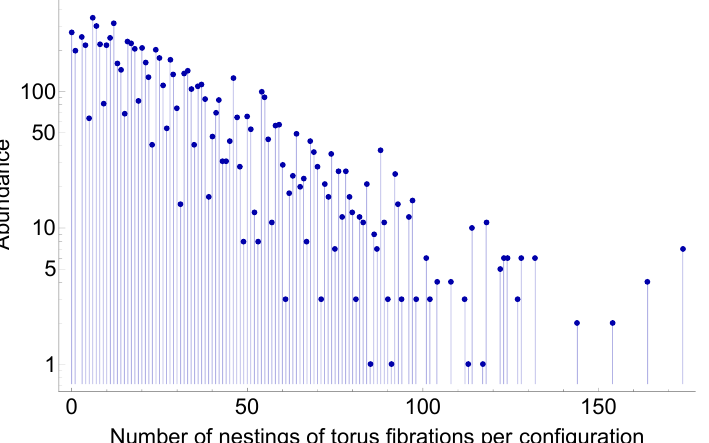
Figure 3 . Distribution of the abundance of obvious torus (cid:12)brations nested inside obvious K3 (cid:12)bra- tions in the CICY threefold list (excluding product manifolds). The values lie in the range 0{174. We (cid:12)nd 208 ; 987 such nested (cid:12)brations in total and on average each CICY threefold